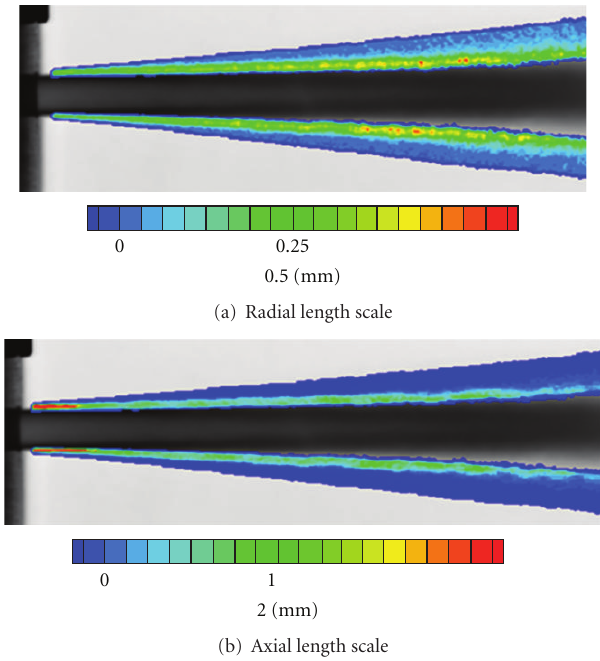
Figure 4: Experimental length scales for LN 2 into GN 2 , chamber pressure of 4MPa, LN 2 injected temperature of 123 K. Branam and Mayer [13].